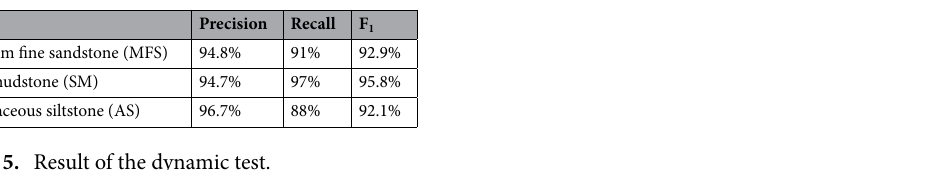
Table 5. Result of the dynamic